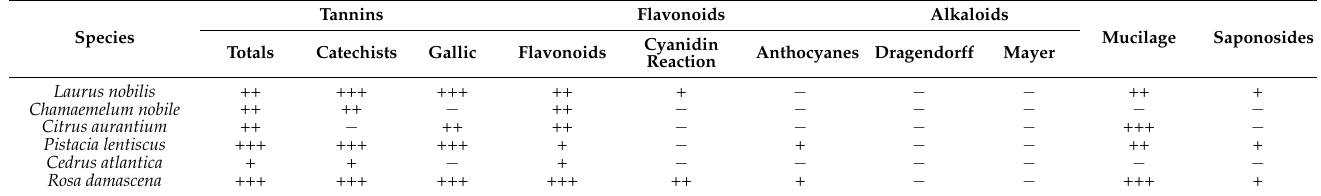
Table 4. Screening secondary metabolites of the plants